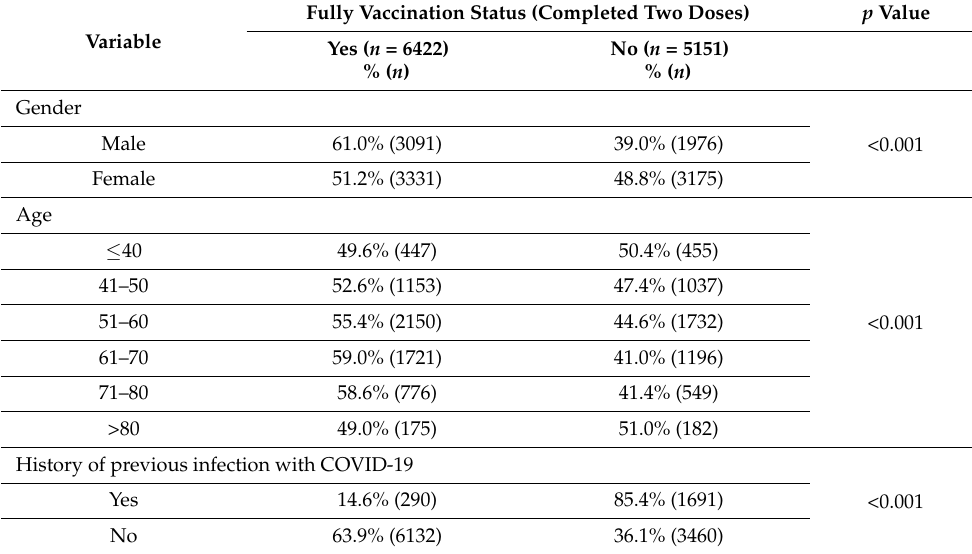
Table 4. Association between full vaccination status and patient characteristics.